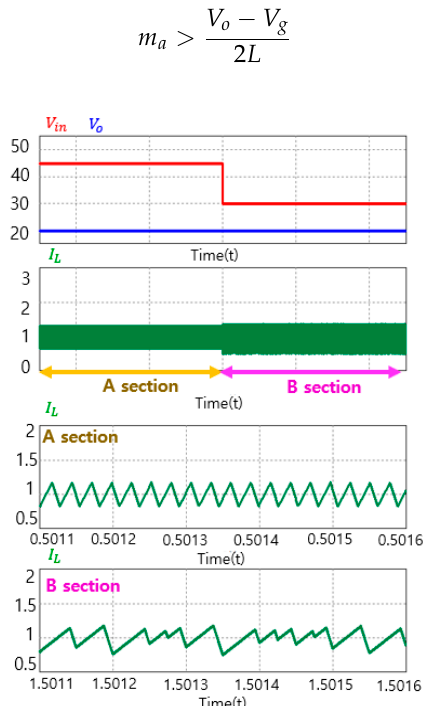
Electronics 2018 , 7 , x FOR PEER REVIEW Figure 8. Inductor current waveform for changing input voltage. Figure 8. Inductor current waveform for changing input voltage.